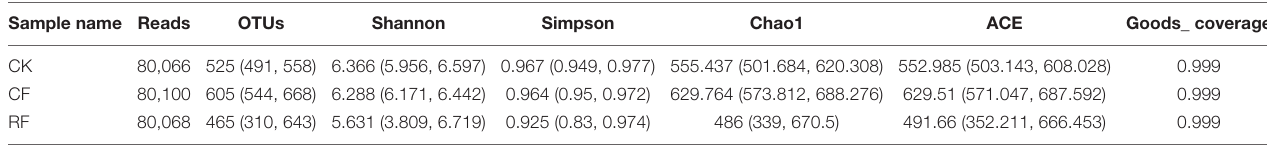
TABLE 3 | High-throughput sequencing results and α -diversity index of cassava rhizospheric soil samples.